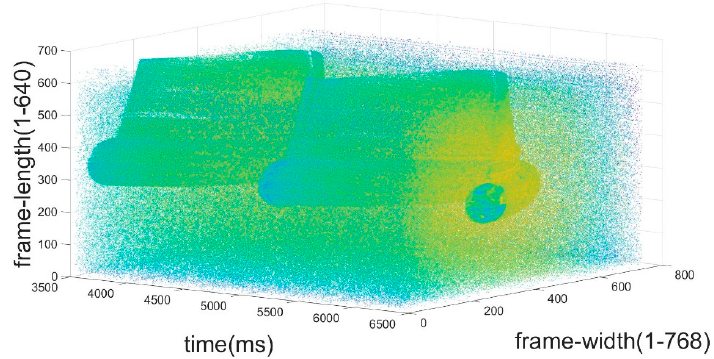
Figure 3. The spatiotemporal image of the original event stream.